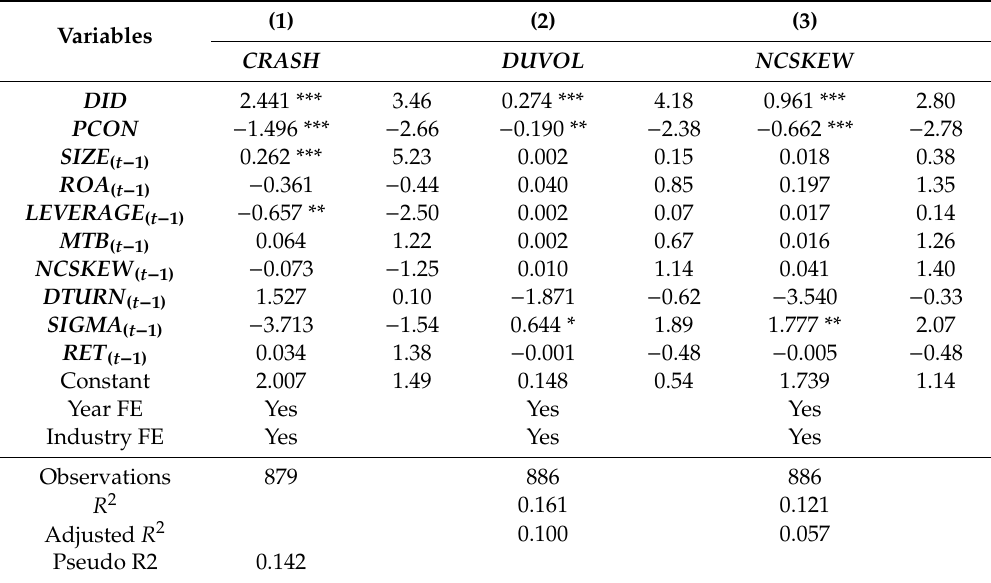
Table 8. Di ff erence-in-di ff erence results (including year of Suharto’s resignation,